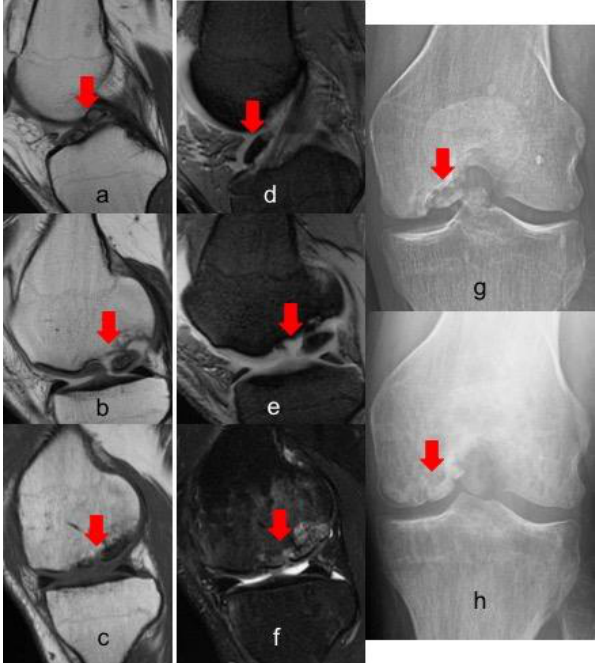
Figure 3. MRI and X-ray evolution of a grade IV OCD of 4.6 cm 2 in the medial condyle of a right knee fixed with three Smart Nails. ( a , b ) T1 preoperative sagittal view; ( d,e ) T2 preoperative sagittal view; ( c – f ) 1 year postoperative sagittal view; ( g ) preoperative X-Ray; ( h ) 5 years postoperative X-ray. In all images the red arrow indicates the lesion, in figure a-d the red flag indicates a free intra-articular body.